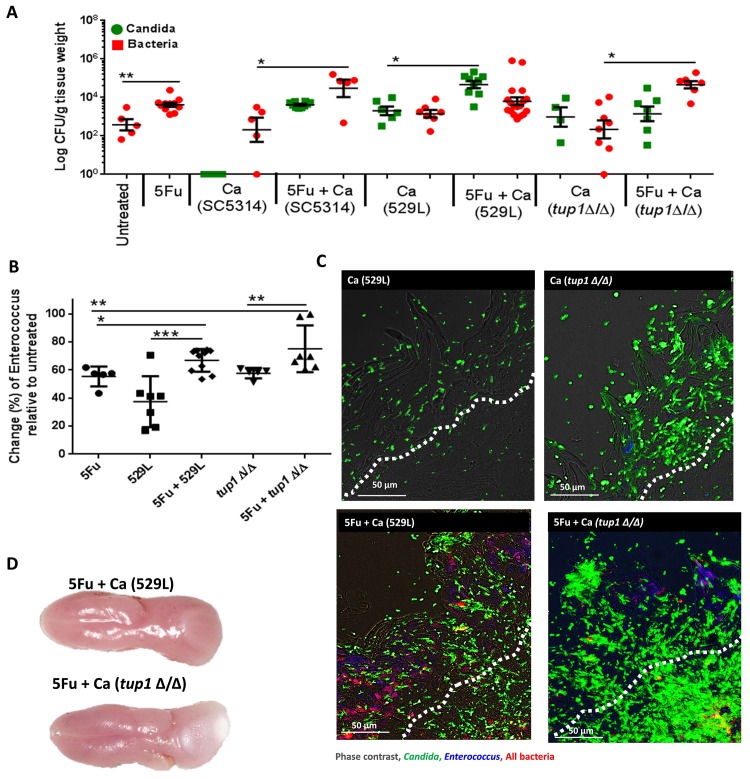
Effects of different C. albicans strains and 5Fu on oral bacteria.A: Recovery of C. albicans (green) and total cultivable bacteria (red) from tongues of untreated mice, mice receiving 5Fu, mice receiving C. albicans (Ca) and a combination (5Fu+Ca). C. albicans strains SC5314, 529L or the tup1Δ/Δ deletion mutant were used in these experiments. Tongues were weighed, homogenized, serially diluted and plated for CFU counts. Strains 529L and tup1Δ/Δ were able to stably colonize the tongue mucosa in the absence of 5Fu, however, this was not associated with increased oral bacterial loads. On the other hand the combination of 5Fu with both strains led to increased bacterial loads. Log CFU counts/gm of tissue are shown from 2 independent mouse experiments, with 4–8 mice per group; bars represent means ± SEM. *p<0.01, **p<0.0001. B: Tongue-associated Enterococcus biomass as assessed by genus-level qPCR. Data represent percentage change of Enterococcus genome copy numbers relative to untreated mice. Groups included untreated mice, mice receiving 5Fu, strain 529L alone, strain 529L + 5Fu, the tup1Δ/Δ deletion mutant alone and the tup1Δ/Δ deletion mutant + 5Fu. All treatments led to an increase in the enterococcal biomass, however mice receiving both 5Fu and C. albicans had the highest increase. Results shown are from 5–8 mice per group in two experiments; bars represent means ± SEM. *p<0.05, **p<0.005, ***p<0.002. C: Tongue tissue sections from mice receiving C. albicans 529L or tup1Δ/Δ deletion mutant in the absence (left panel) or presence (right panel) of concomitant 5Fu chemotherapy for 8 days. Tissue sections were triple-stained with the all bacteria probe EUB338 (red), the E. faecalis specific probe ENFL84 (blue), and anti-Candida antibody (green). Enterococcal signal shown as purple-blue is clearly visible in mice receiving 5Fu with both strains. In these mice there was fungal invasion into the oral submucosa (bellow the white dotted line), which was more pronounced with the tup1Δ/Δ mutant. D: Representative tongues excised from mice receiving 5Fu with strain 529L (top) or the tup1Δ/Δ deletion mutant (bottom), 8 days after infection. Note the white biofilm area in the posterior surface with the tup1Δ/Δ deletion mutant.